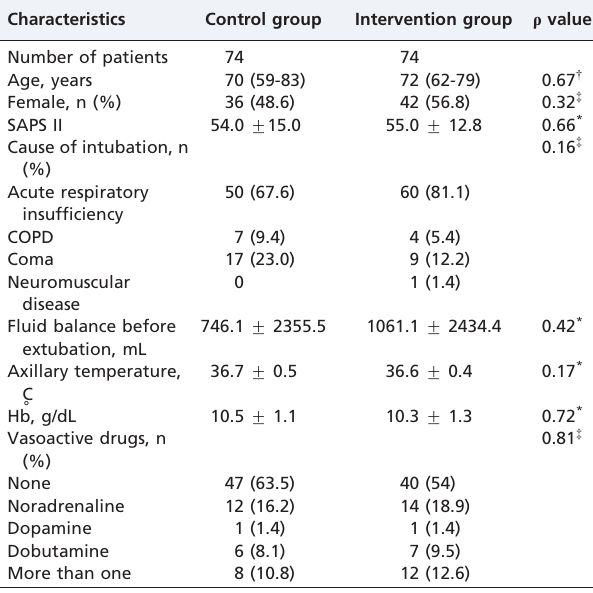
Table 1 - Clinical and demographic characteristics of the study